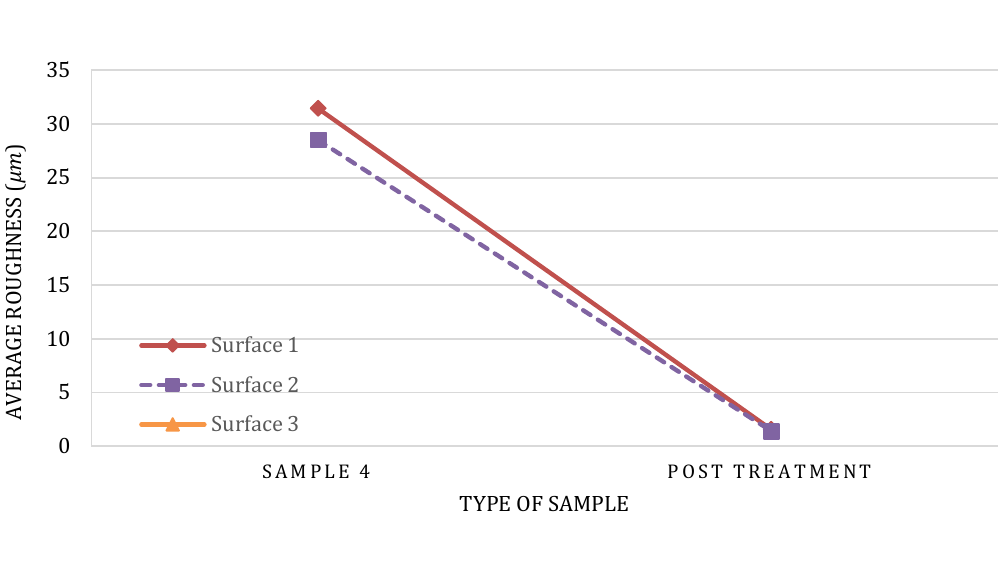
Figure 7: Comparison of surface roughness between untreated sample and sample after post treatment